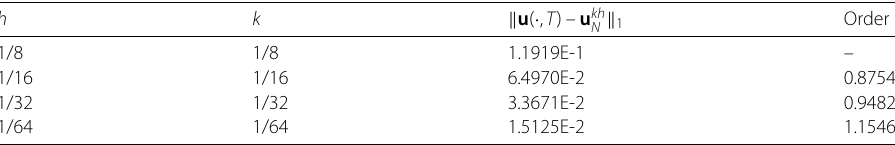
Table 1 Convergence orders of the errors with h =